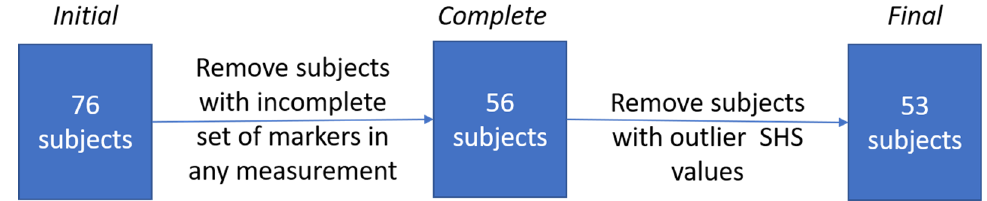
Figure 1. The procedure of selecting subjects for the final trial. SHS: Suzuki’s Hump Sum.